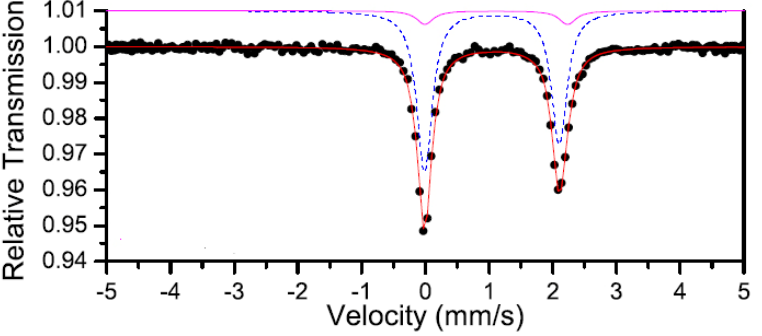
Figure 39. Room temperature Mössbauer spectrum of orthopyroxene extracted from São João Nepomuceno IVA-an iron meteorite. Indicated spectral components are the result of the fit. Adapted from [99].